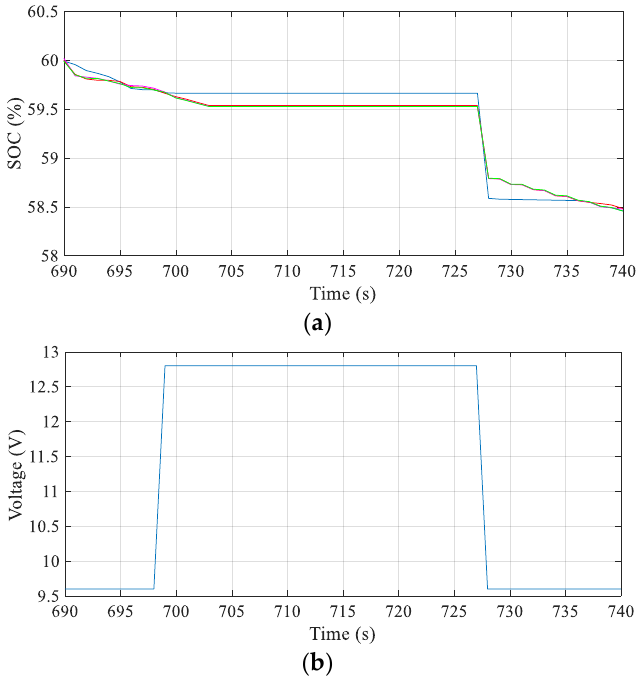
Figure 15. ( a ) SOC in the master during communication loss; ( b ) output battery pack voltage.